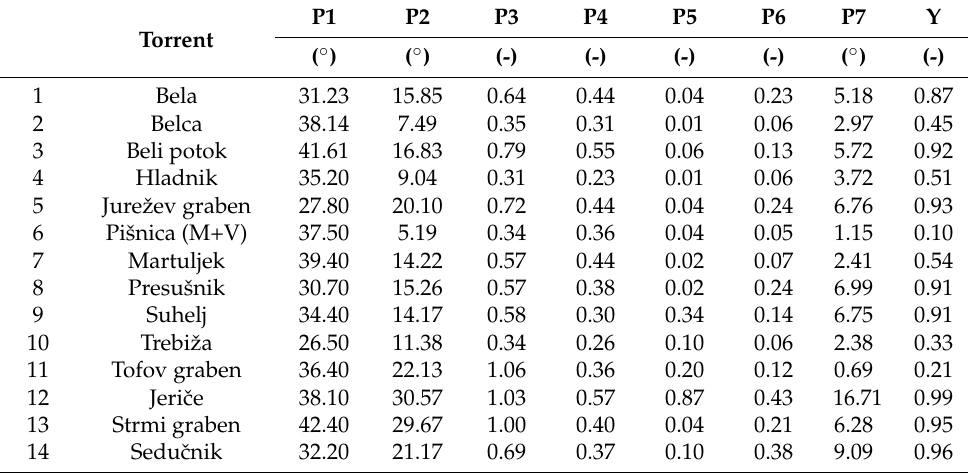
Table 3. Parameters of all alluvial (torrential) fans.